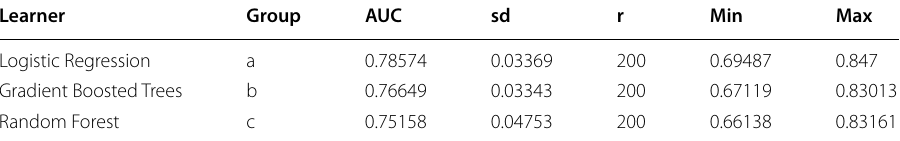
Table 13 Two-factor Tukey’s HSD learner results over all datasets Learner